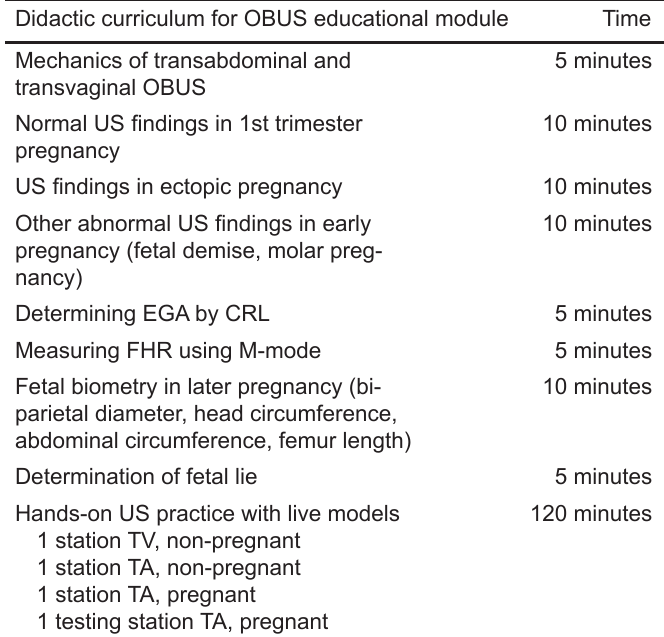
Table 1. Details of the OBUS training